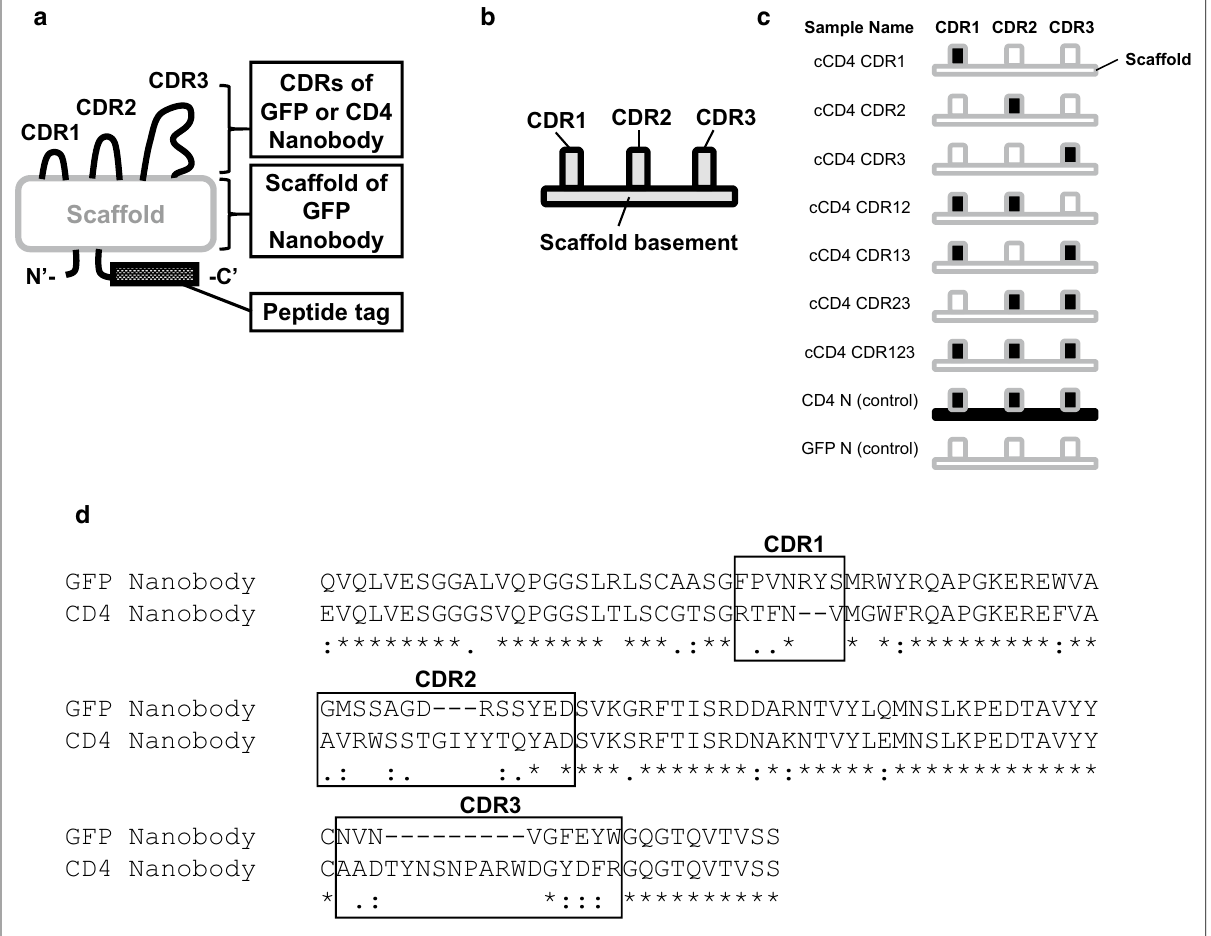
Fig. 1 Chimeric nanobodies prepared in the present study. a Construction of chimeric nanobodies. Peptide tags were fused to the C-terminus of nanobodies. b Simple illustration of a nanobody used for swapping. c Name and construction of chimeric nanobodies. Long white block: nanobody scaffolds with amino acid sequences derived from GFP-nanobody, long black block: nanobody scaffolds with amino acid sequences derived from CD4-nanobody, small white block: CDRs with amino acid sequences derived from GFP-nanobody, small black block: CDRs with amino acid sequences derived from CD4-nanobody, cCD4 CDRX: chimeric nanobody with CDRX of GFP-nanobody replaced with that of CD4-nanobody, CD4N: CD4 -nanobody with peptide tags containing two FLAG-tag sequences (see also Additional file 1: Table S3), GFPN: GFP-nanobody with peptide tags containing two FLAG-tag sequences (see also Additional file 1: Table S3). d Amino acid sequence alignment of GFP- and CD4-nanobodies prepared by CLUSTALW (Larkin et al. 2007). Asterisks indicate identical amino acids. Colons indicate similar amino acids. Dots indicate almost similar amino acids. Blanks indicate non-homologous amino